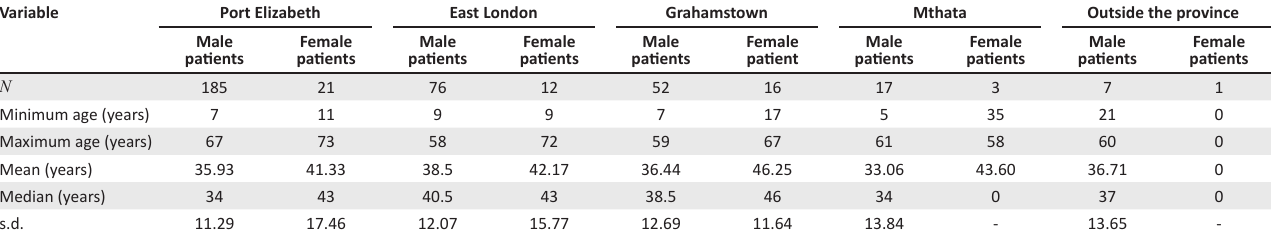
TABLE 2: Descriptive statistics per region at admission to Tower Psychiatric Hospital and Psychosocial Rehabilitation Centre.